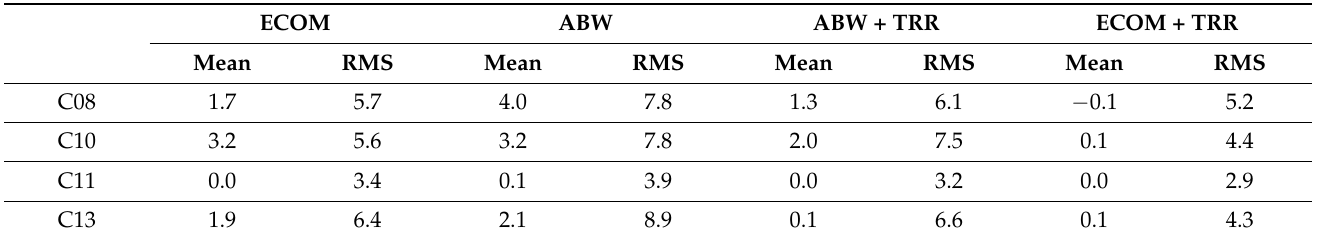
Figure 11. Distribution of the SLR residual for the ECOM + TRR orbit solution with respect to the Sun elongation angle for the BDS-2 C08, C10, C11, and C13 satellites.